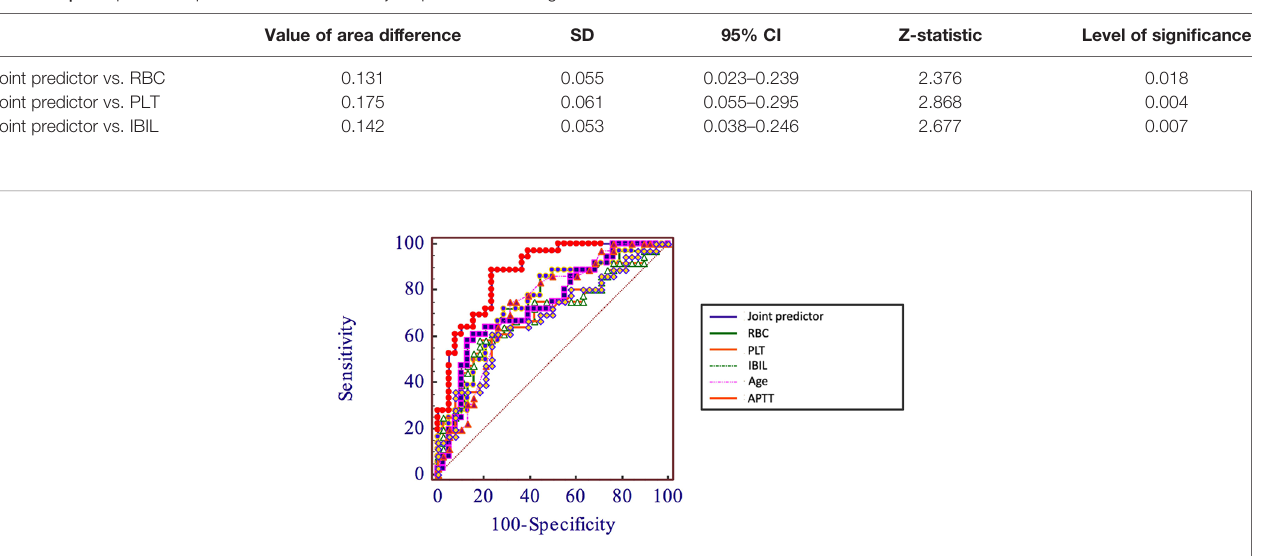
TABLE 8 | Comparison of predictive value between joint predictor and single variable.